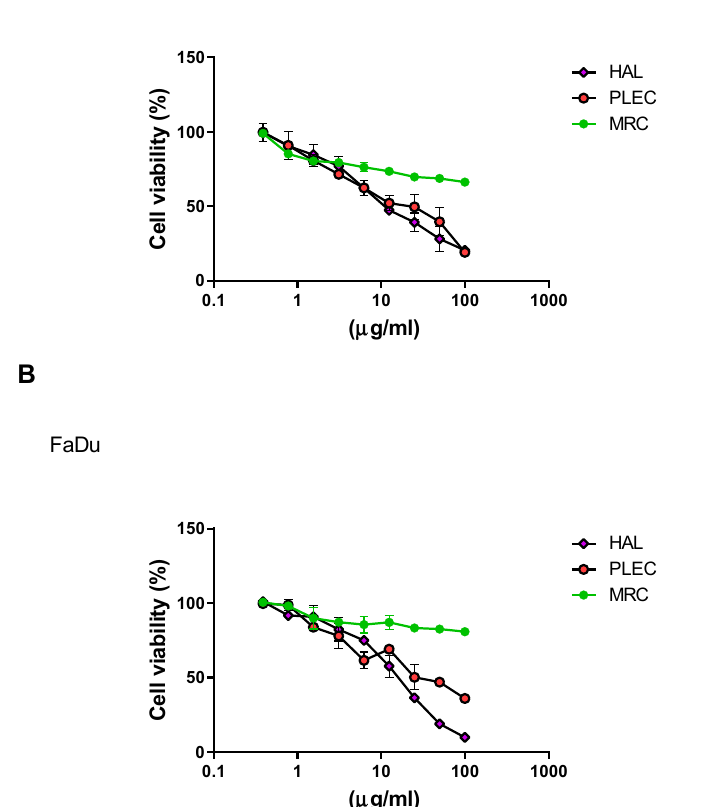
Figure 1. Effects of HAL, PLEC and MRC on the viability of ( A ) MCF7, ( B ) FaDu cells, as determined by the MTT assay. Values represent the means ± SD as percent (%) of control values. Values on the X -axis are shown as log10.